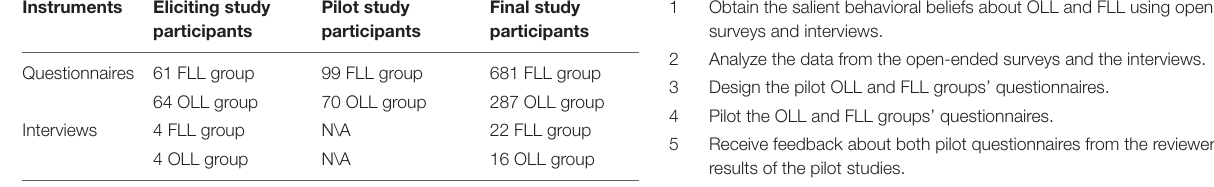
TABLE 1 | Number of participants in the study. Instruments